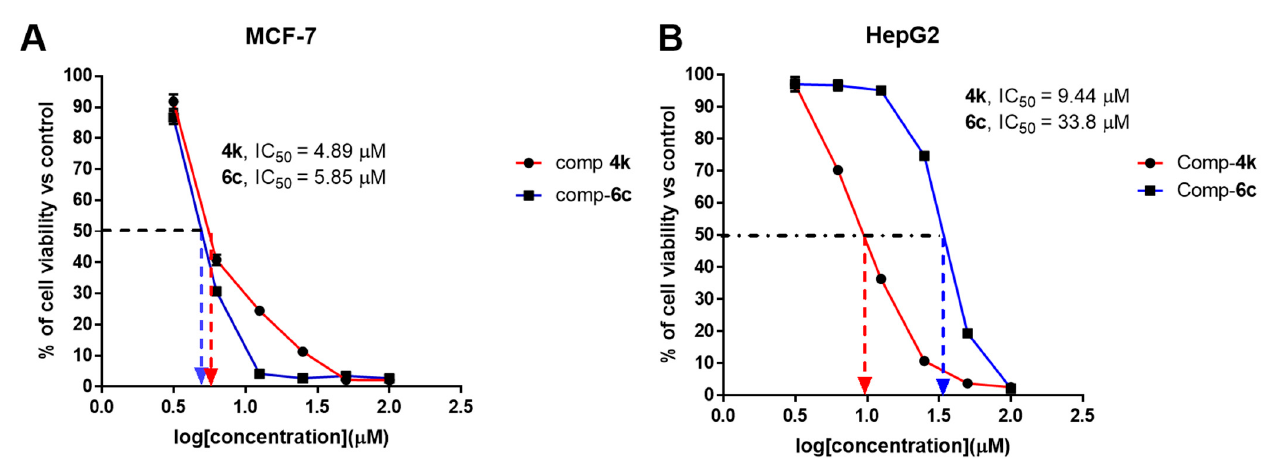
Figure 5. Dose-response curve for the cytotoxicity of two hit compounds 6c and 4k against ( A ): MCF-7 and ( B ): HepG2 cell lines for 48 h using MTT assay. Half minimal inhibitory concentration (IC 50 ). Table 3. Inhibitory activities of the hit compounds towards topoisomerase II, VEGFR2 target enzymes.